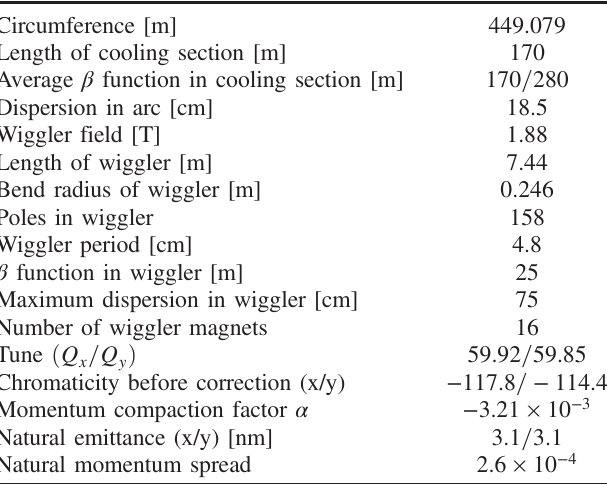
TABLE II. Parameters of the ring